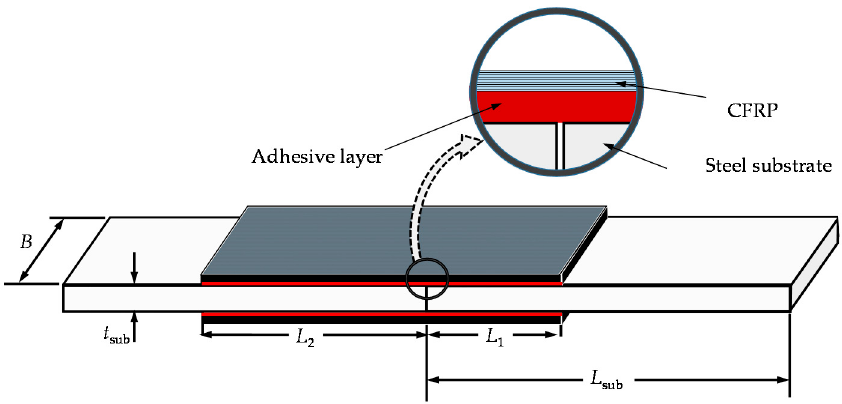
Figure 1. A schematic of steel/CFRP double strap joint. Table 1. Mechanical properties of materials used for experiments.